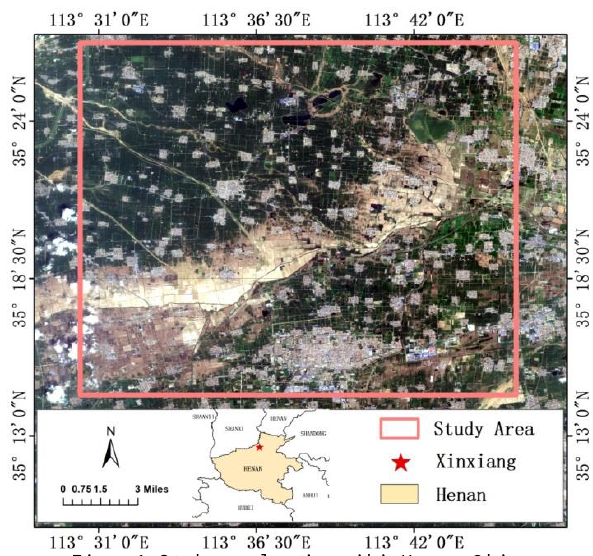
Figure 1. Study area location within Henan, China